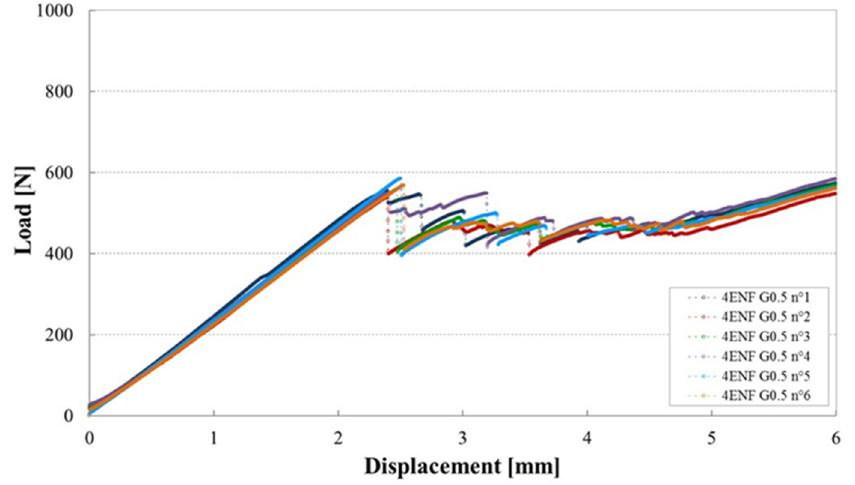
Figure 11. Load–displacement plots for tests on six 4ENF specimens containing a Gap of 0.5 mm manufactured with a caul plate.